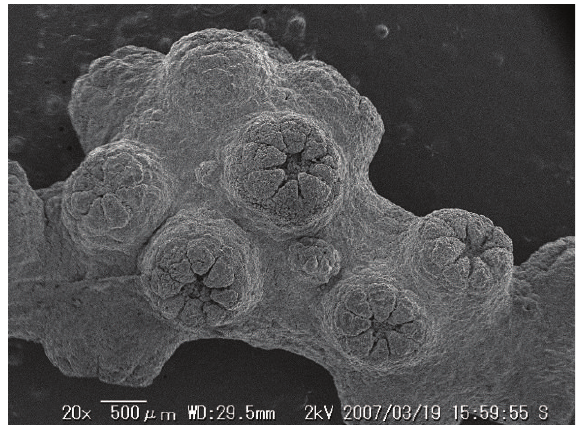
Figure 15: SEM image of coenenchyme surface of Corallium elatius ;